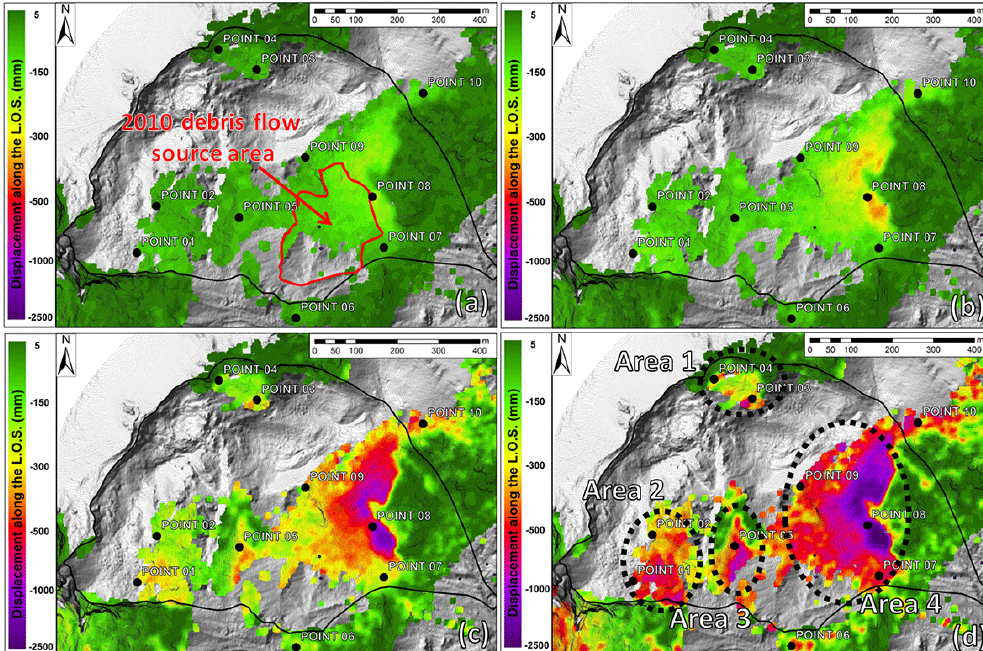
Figure 7. ICD maps of the Rotolon landslide: (a) 8 December 2010–1 January 2011; (b) 8 December 2010–1 February 2011; (c) 8 De- cember 2010–1 December 2011; (d) 8 December 2010–31 December 2012 (points 1–10 represent the GB-InSAR measurement points in correspondence of which the displacement time series were extracted).